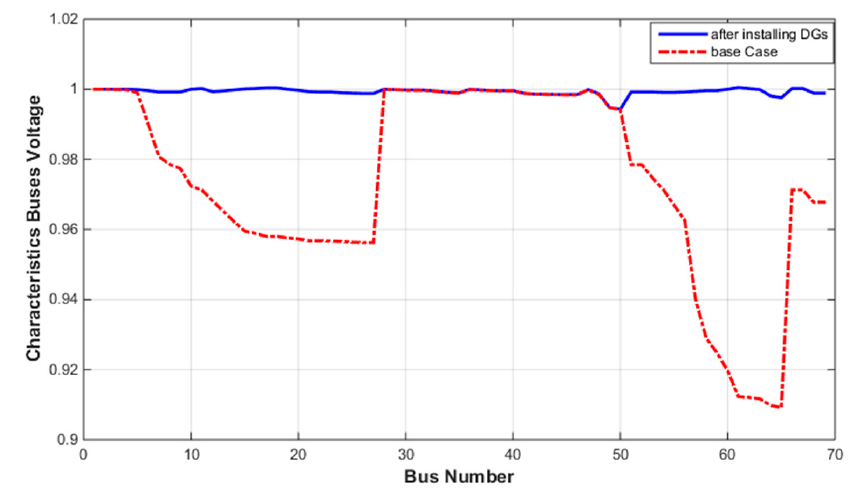
Figure 27. Characteristics of voltage at 0.82 pf.